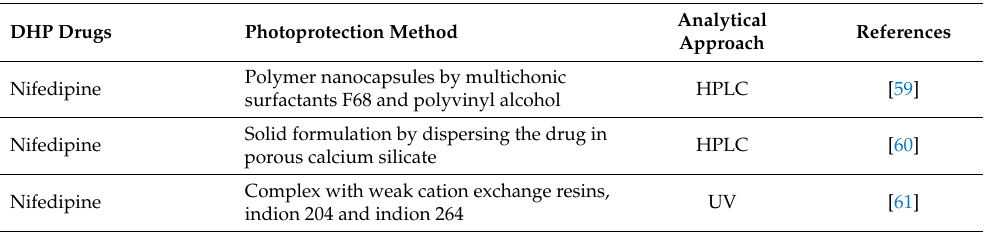
Table 5. Incorporation in